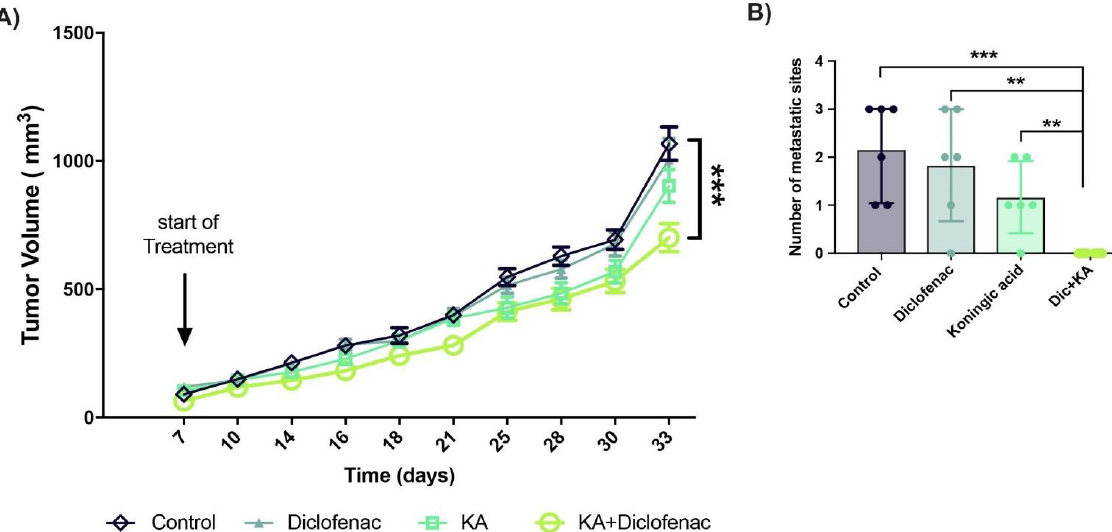
Figure 5. Animal experiments confirm the efficiency of evolutionary designed therapy. ( A ) Female NSG mice injected with a mixture of 5 million MCF7 and 5 million MDA-MB-231 breast cancer cells and randomized into four groups of 6 and treated with, DMSO, diclofenac, KA, and combination. Tumor size is measured every two or three days by calipers and also once a week with ultrasound. Data is presented is measurements by calipers and are mean with SD as their error bars. ( B ) The number of metastasis sites in vital organs such as liver, lungs, kidney, and spleen at the endpoint. The data is represented as mean with the error bars as the SD. p -values are represented as follows: ** p < 0.01, *** p <